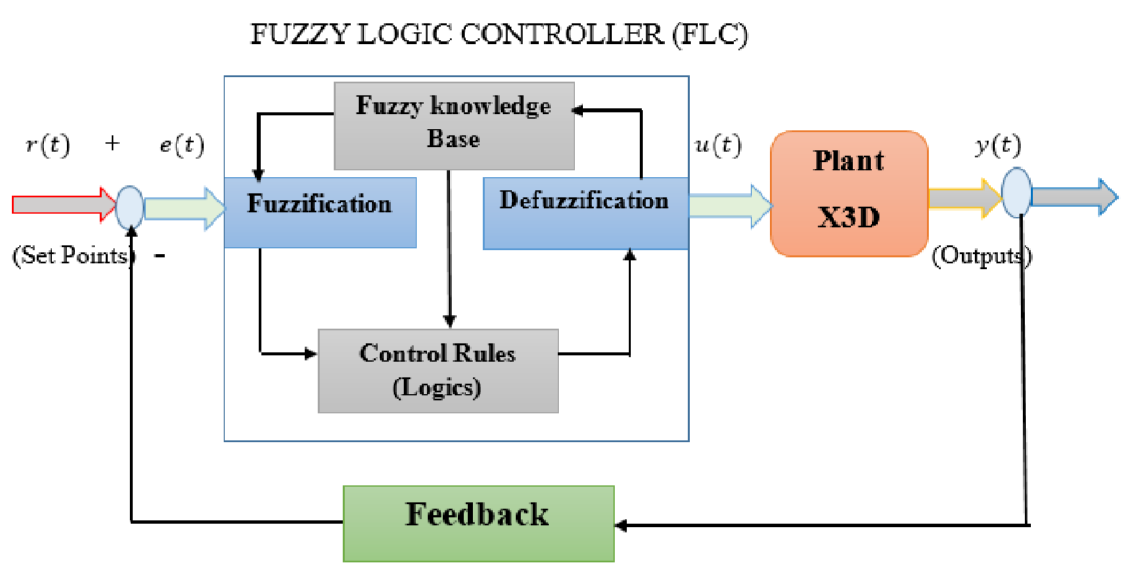
Figure 6. X3D Quadrotor Control using a Fuzzy Controller.